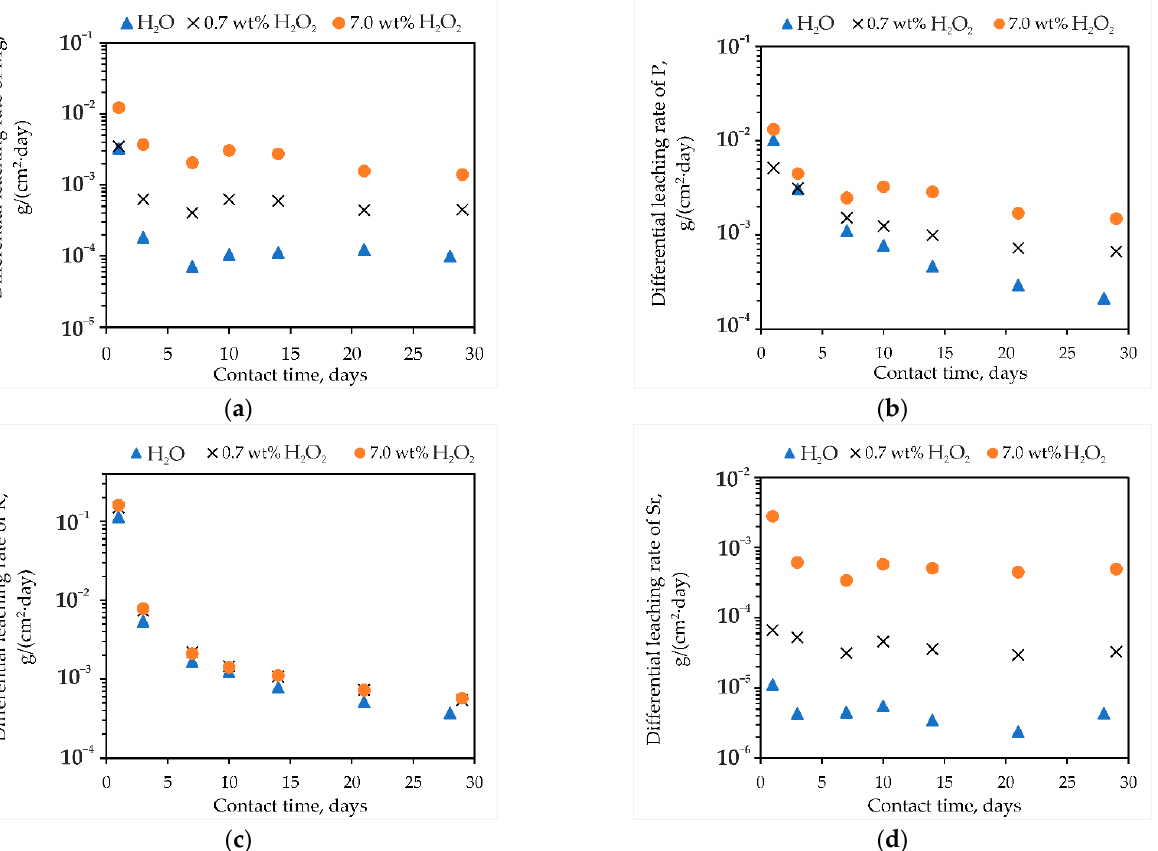
Figure 6. Kinetic curves of the leaching rates of ( a ) Mg, ( b ) P, ( c ) K, and ( d ) Sr from MPP-Z compound after its heat treatment at 180 ◦ C as a function of the hydrogen peroxide content in the contact